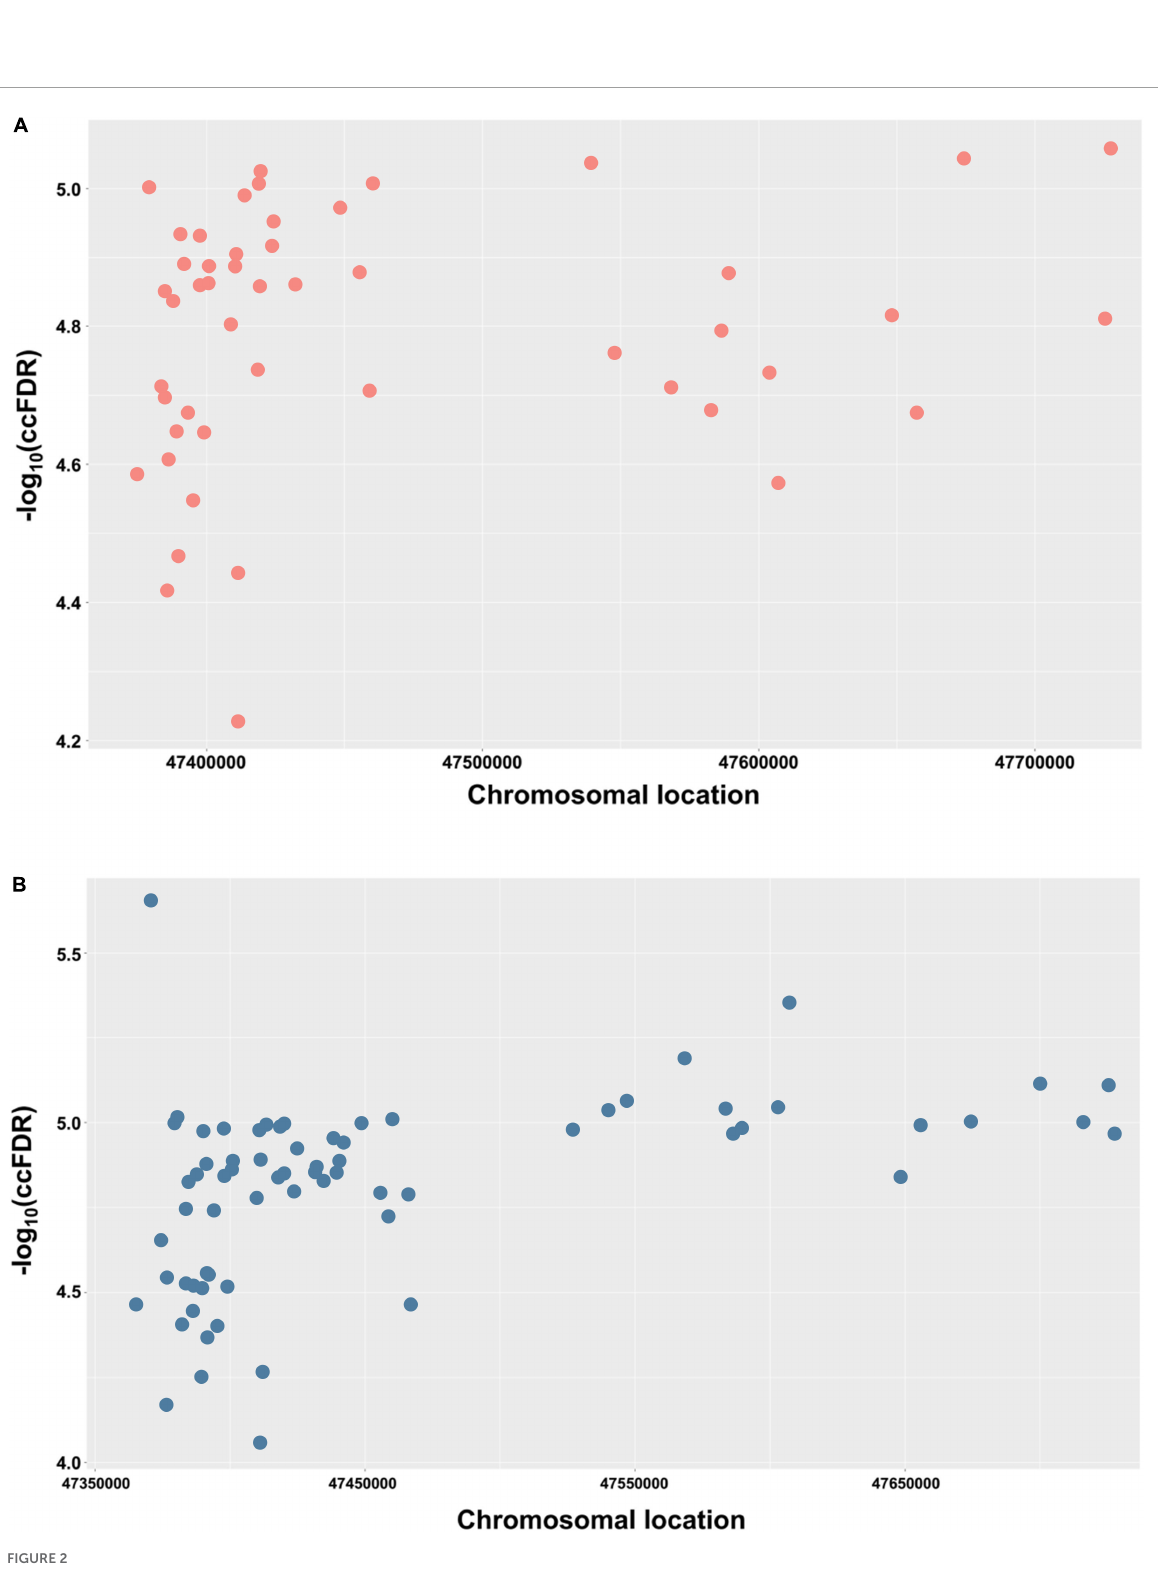
FIGURE2 Conjunctional Manhattan plots depict the chromosomal location of each tested shared genetic loci between AD and glaucoma. (A) Conjunctional Manhattan plot of chromosomal locations and –log 10 (ccFDR) values for associated SNPs of AD and glaucoma discovery sample. (B) Conjunctional Manhattan plot of chromosomal locations and –log 10 (ccFDR) values for associated SNPs of AD and glaucoma replication sample. The X -axis is the chromosomal locations of significant shared loci. The Y -axis is the calculated –log 10 (ccFDR) of significant shared loci. Detailed information about chromosomal locations for all significant loci is shown in Table 1